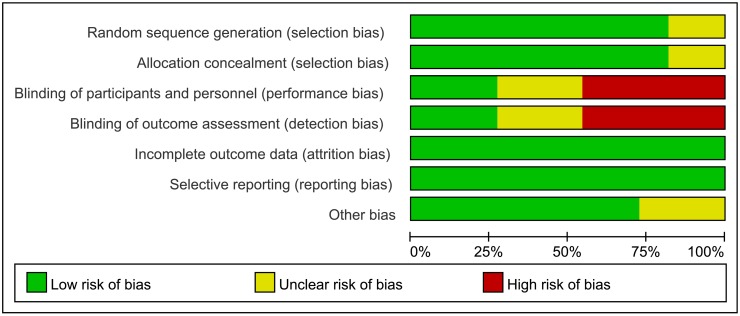
Risk of bias graph.